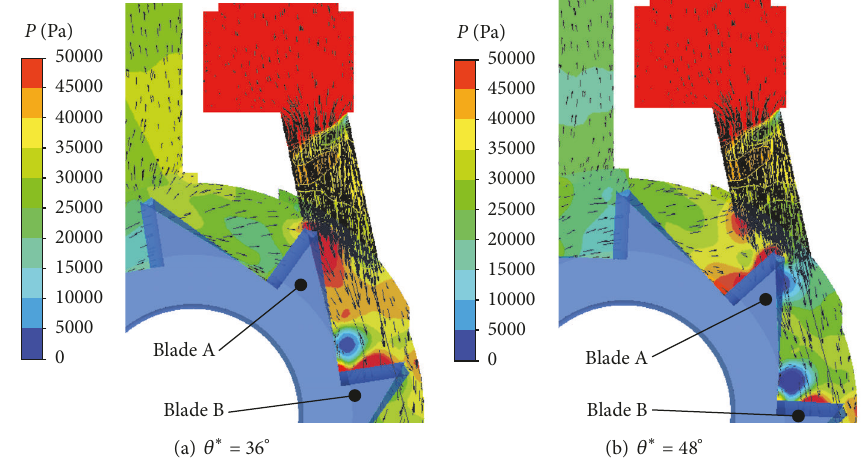
Figure 16: Static pressure distributions and absolute velocity vectors ( 𝑛 = 250 ,000 min −1